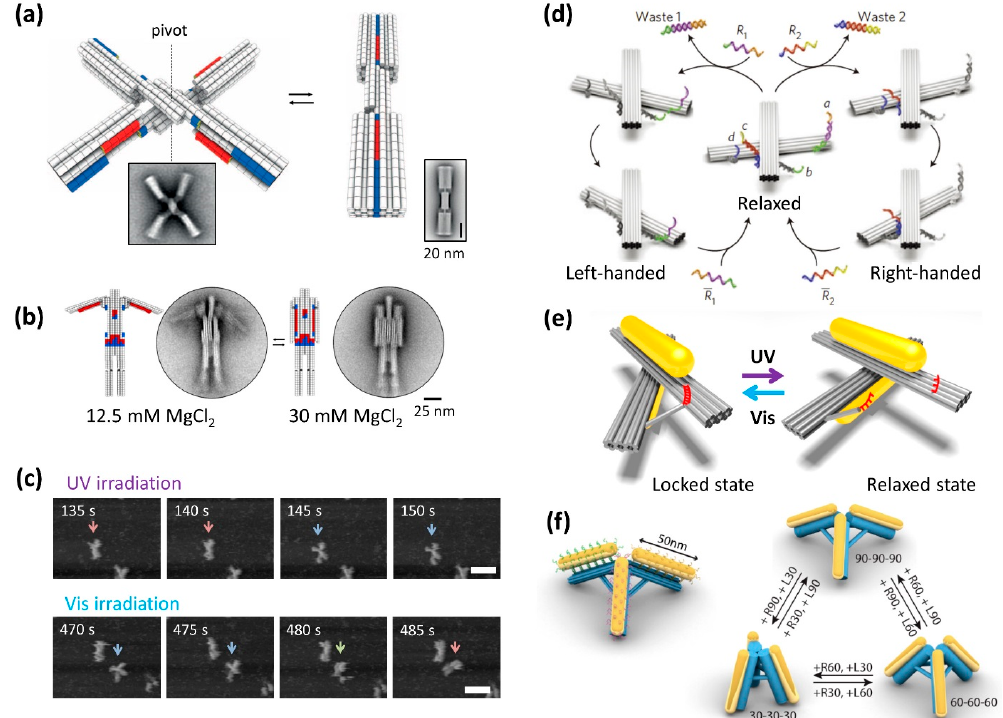
Figure 4. Reconfigurable DNA origami structures that change their conformation in response to physical stimuli and DNA strands. ( a ) DNA dynamic nanodevice that responses to temperature and salt concentration. Two domains can rotate around the center axis. The nanodevice reversibly opens and closes in response to temperature [24]. ( b ) A molecular robot that opens and closes the arms in response to salt concentration. ( c ) HS-AFM images of conformational changes of the DNA nanodevice with photoswitching strands and UV and Vis irradiation [25]. ( d ) Reconfigurable DNA nanostructure in left-handed and right-handed locked states controlled by strand displacement with toehold-containing DNA strands [26]. ( e ) Plasmonic nanostructure with two gold nanorods (AuNR), and locked and relaxed state can be controlled with photo-responsive DNA strands and UV/Vis irradiation [27]. In response to light, a locked state and a relaxed state occur, and spectroscopically read out according to the plasmon interaction between the AuNRs. ( f ) Reconfigurable DNA origami tripod with AuNRs. Releasing strands (R) and locking strands (L) are employed to stepwise manipulation of the angle between the DNA arms [28].